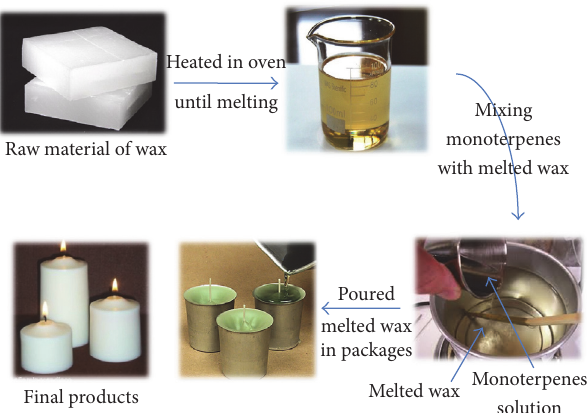
Figure4:Schematicillustrationofthepreparationofmonoterpenes incorporated into wax for mosquito control